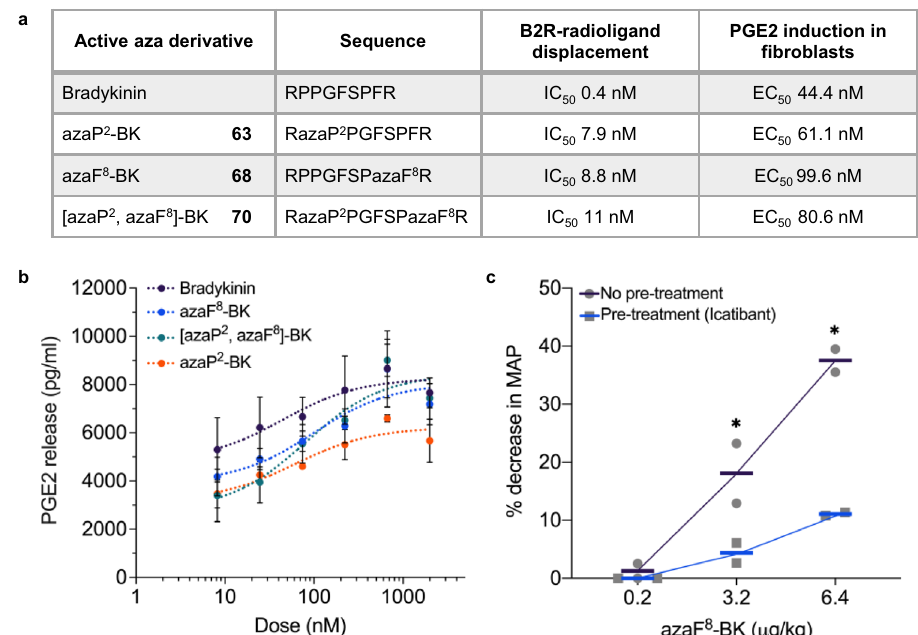
Fig. 5 | Bioactivities of selected bradykinin azapeptide analogues. a Selected bradykinin azapeptide analogues displace a radioactive B2R receptor ligand in the nanomolarrange(IC 50 ’ s)andinduce fi broblastprostaglandinE2(PGE2)production (EC 50 ) in vitro. EC 50 ’ s for bradykinin- and bradykinin azapeptide analogue-induced PGE2 release (right most column) were determined by least squares regression analysis of data plotted in Fig. 5b without weighting and were not signi fi cantly different between data sets, as determined by one-way ANOVA on ranks (Kruskal – Wallis H -test). b Bradykinin and bradykinin azapeptide analogues azaP 2 - BK ( 63 ), azaF 8 -BK ( 68 ) and [azaP 2 , azaF 8 ]-BK ( 70 ) dose-dependently stimulate the production of PGE2 in 3T3 cells. Subcon fl uent monolayers of 3T3 cells were incu- batedwithtestcompoundsfor7mininserum-freemediumandsupernatantswere Integration of the thiocarbazate amino acid in SPPS Procedure A . Wang or Rink amide amino acid-loaded resin (0.1 mmol) was swelled for 10 min in DMF (2.5mL × 2), followed by Fmoc cleavage using 20% solution of piperidine in DMF (2.5mL×2)/2min per clea- vage cycle. After successive washes with DMF (2.5mL× 3)/30s per wash and with DCM (2.5 mL ×5)/ 30s per wash. The resin was then